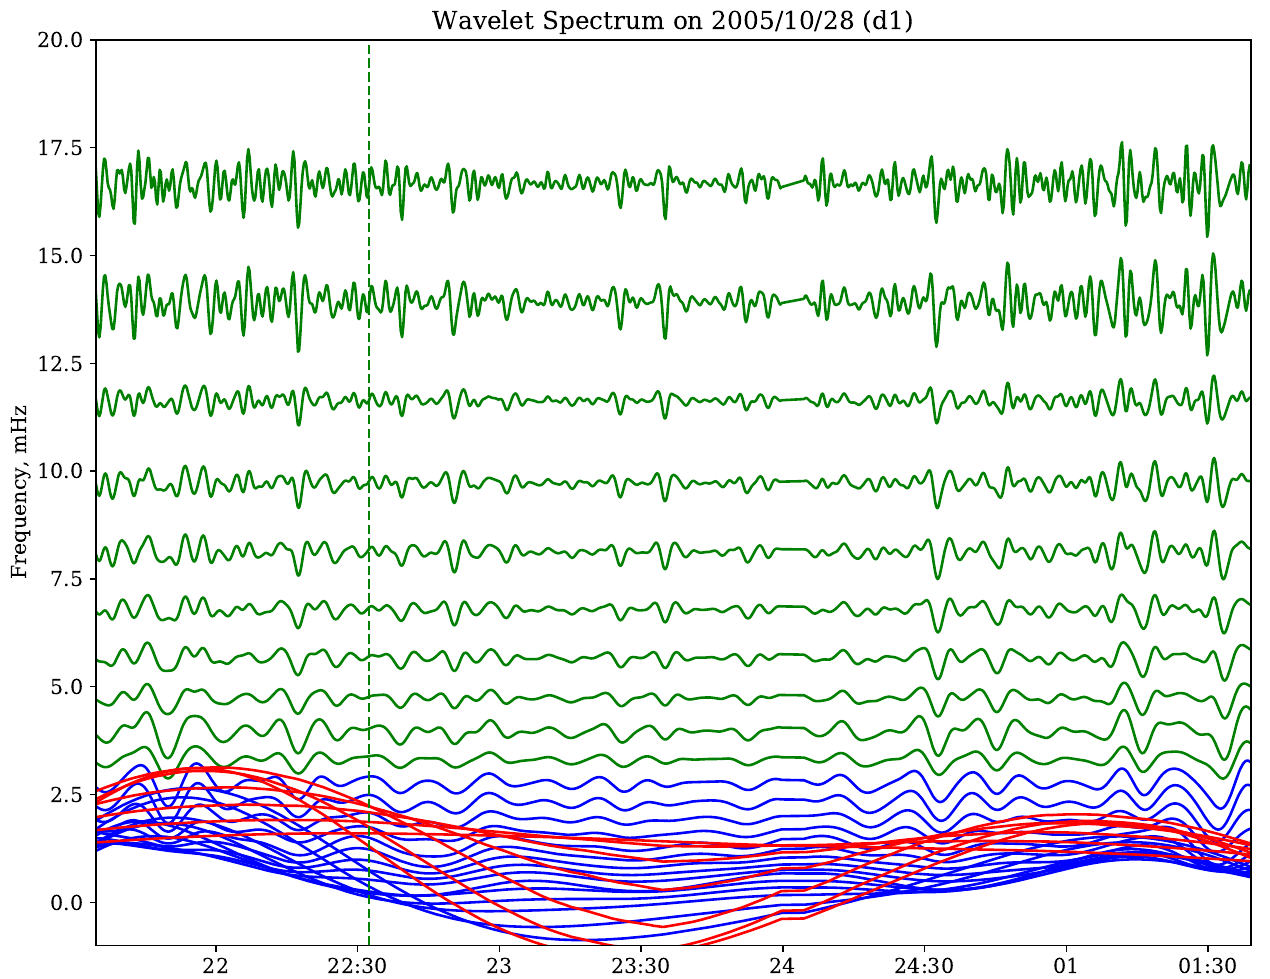
Figure 3. Wavelet spectrum of the average Doppler velocity of FAI-E on 28 October 2005 . The average is taken over altitudes between altitudes of 90 and 110 km. The spectral amplitudes are normalized to the maximum spectral amplitude, where the maximum is taken over all frequencies and the entire time duration. For better visualization, the normailzed amplitude is multiplied by a factor of 3. The dashed-line is drawn at the onset time of the first EPB. The red, blue and green curves correspond to the tidal modes at frequencies below 0.2 mHz, gravity wave modes at frequency in 0.2–2.8 mHz and acoustic wave modes at frequencies above 3.3 mHz,